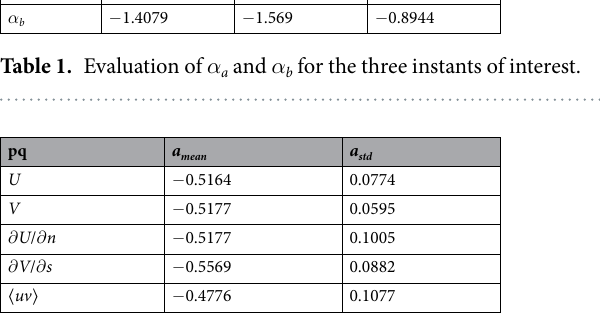
Table 2. Time-averaged and standard deviation of the convergence coefficient a for some physical quantities (pq) of